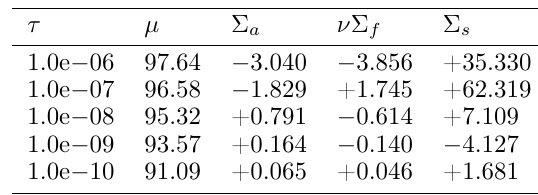
Table 12. Error on macroscopic cross sections after lossy compression by truncated HT on the UGd dataset with matrices M per reaction type only.